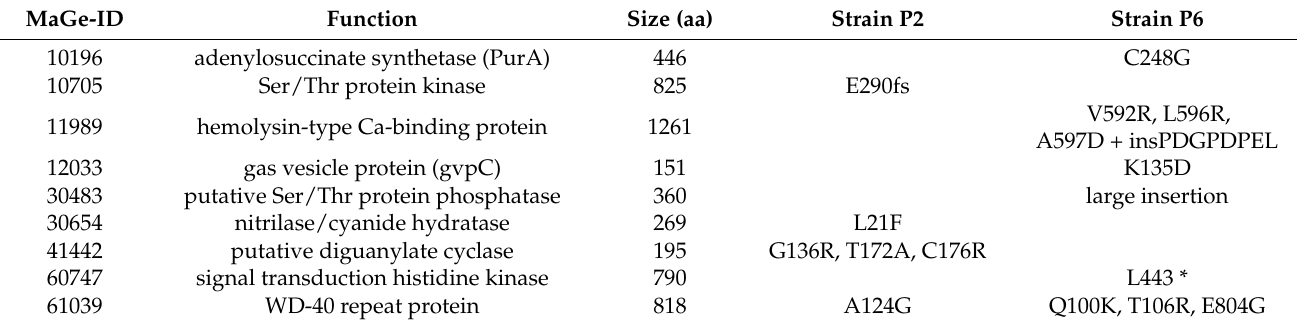
( psbD , encoding the D2 protein of the photosynthesis PSII complex), _60118 (encoding a DNA-[cytosine-5-]-methyl transferase), _60128 (encoding a fibronectin-binding-A-like protein), _60723 (encoding a signal transduction histidine kinase), and _61273 (encoding part of a tetratricopeptide TPR_2 repeat protein). Table 9. Affected CDS with known function in strains P2 and P6 based on genome data (taken from [13]).